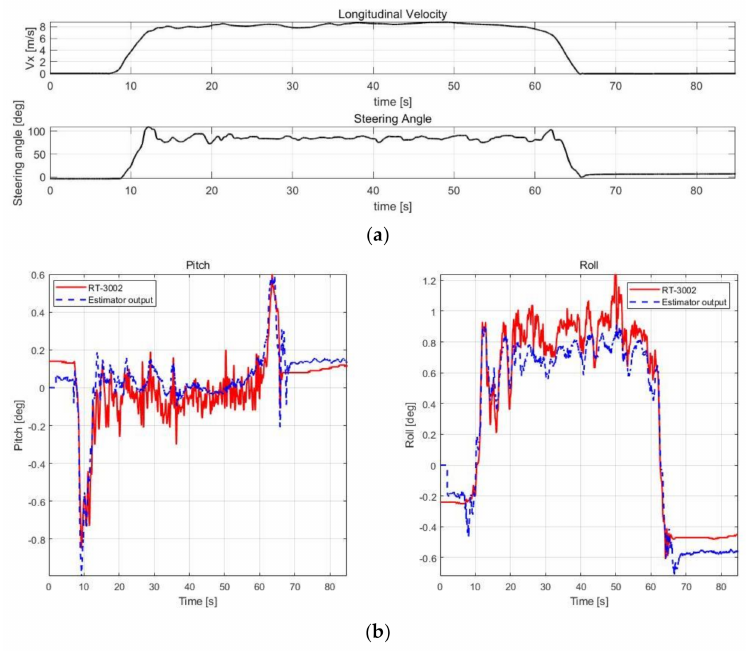
Figure 7. Validation results of Case 3. ( a ) Speed and steering profile. ( b ) Roll/pitch estimation results.